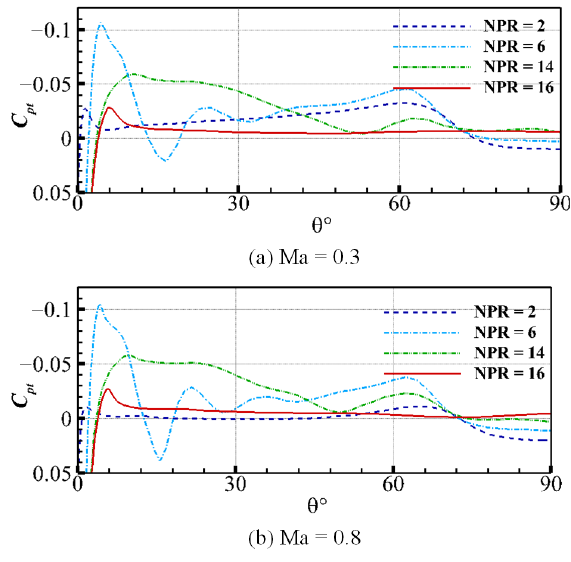
Figure 13. Pressure coefficient C pt on the Coanda surface for Ma = 0.3 and 0.8 at various NPRs. However, the NPRs significantly influence the C pt distribution in both incoming flows, which is reflected in the changes in the CC jet behavior. The Ma contours around the upper trailing-edge surface are shown in Figure 14 to visualize the CC jet behavior. At a moderate blowing pressure with NPR = 2 (Figure 14a), the wave structure is smooth and regular, implying a fully attached boundary layer all along the Coanda surface. Remarkable growth in the oscillation magnitude can be observed at NPR = 6 (Figure 14b). The strong adverse pressure gradient regions in the first two troughs indicate separation. After each separation, there are favorable pressure gradient regions, indicating reattachment. At the critical NPR = 14 (Figure 14c), the first two separated troughs merge, and a small trough follows and extends to the end of the Coanda surface, which indicates that the attachment has become weak. Finally, at NPR = 16 (Figure 14d), the jet flow is vectored from the surface, as the extension of the region of local separation beyond the edge of the Coanda surface allows air at atmospheric pressure to be drawn into the separation bubble. Hence, the boundary-layer control of the CC jet